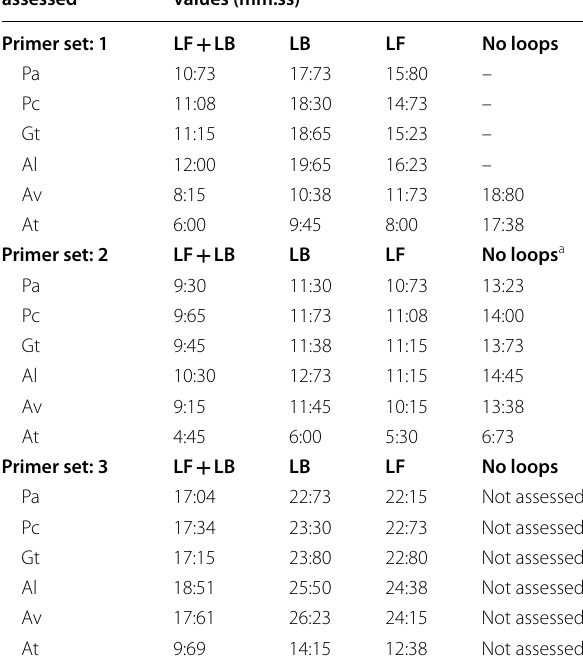
Table 1 A. tomentosa LAMP primers and primer combinations assessed in this study to reduce non-target snail species